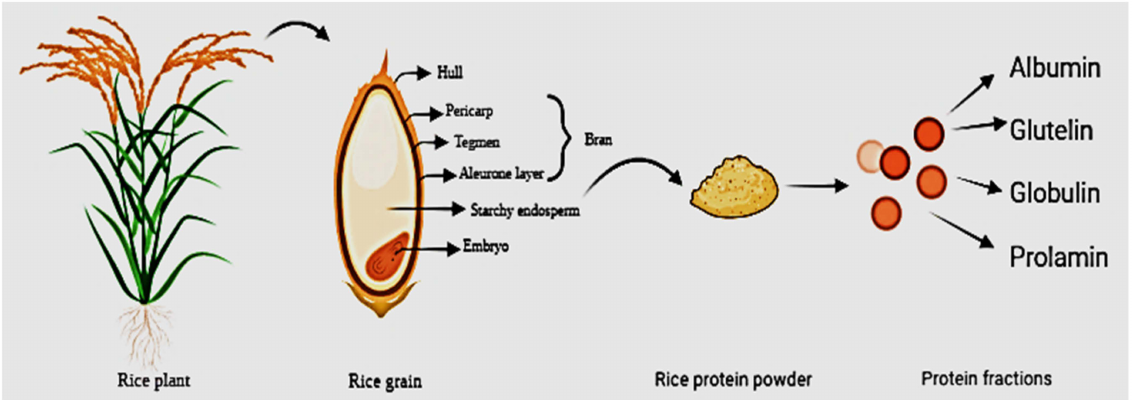
Figure 3. Morphology and internal structure of rice kernel with grain endosperm protein